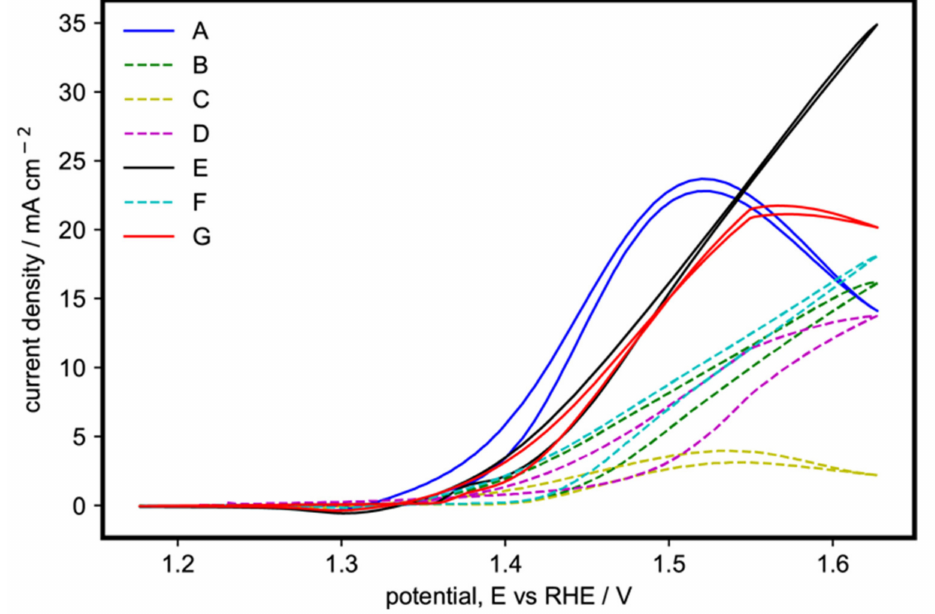
Figure 3. Cyclic voltammogram of the 100th cycle of the Ni(OH) 2 catalysts with varying synthesis parameters on 1 M ethanol and 1 M KOH at 20 mV s − 1